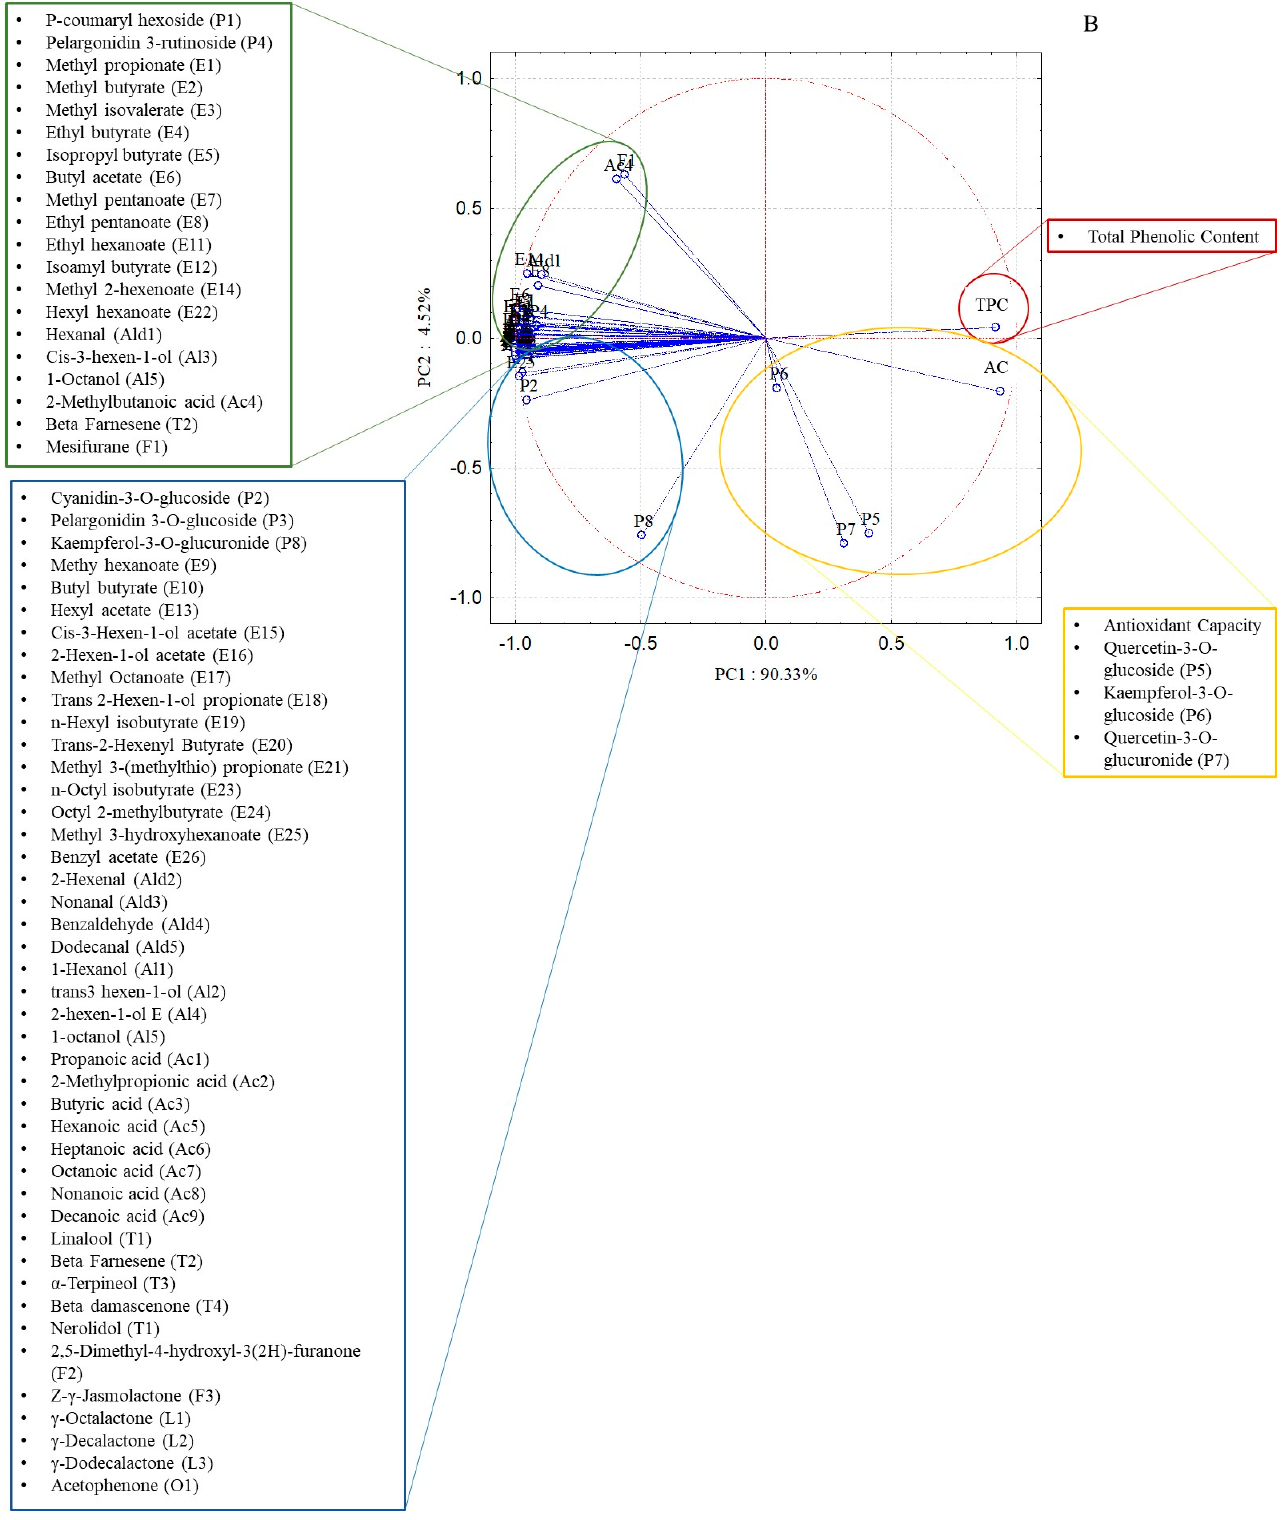
Figure 3. Principal component analysis (PCA) score ( A ) and loading ( B ) plots. The two components accounted for 94.8% of the variation in the dataset, since PC1 and PC2 explained 90.3% and 4.5% of the total variance, respectively. In the PCA plot, all red samples (Red ‐ H1, Red ‐ H2 and Red ‐ H3) appeared in the left part of the score plot,